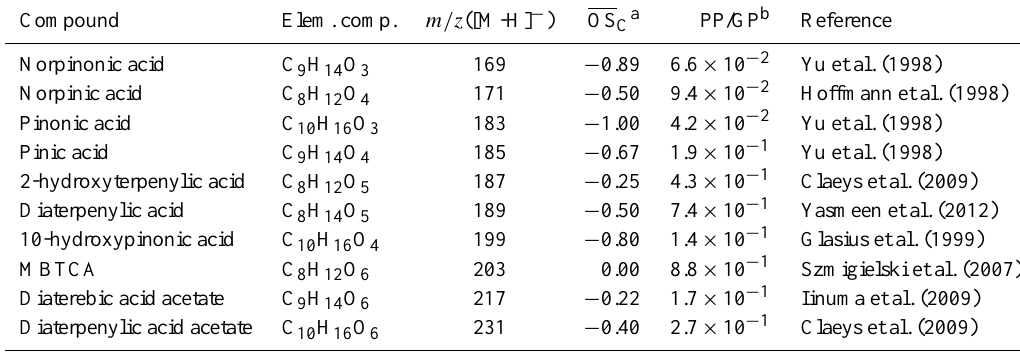
Table 1. Considered literature organic acids for the estimation of OS C . Compound Elem.